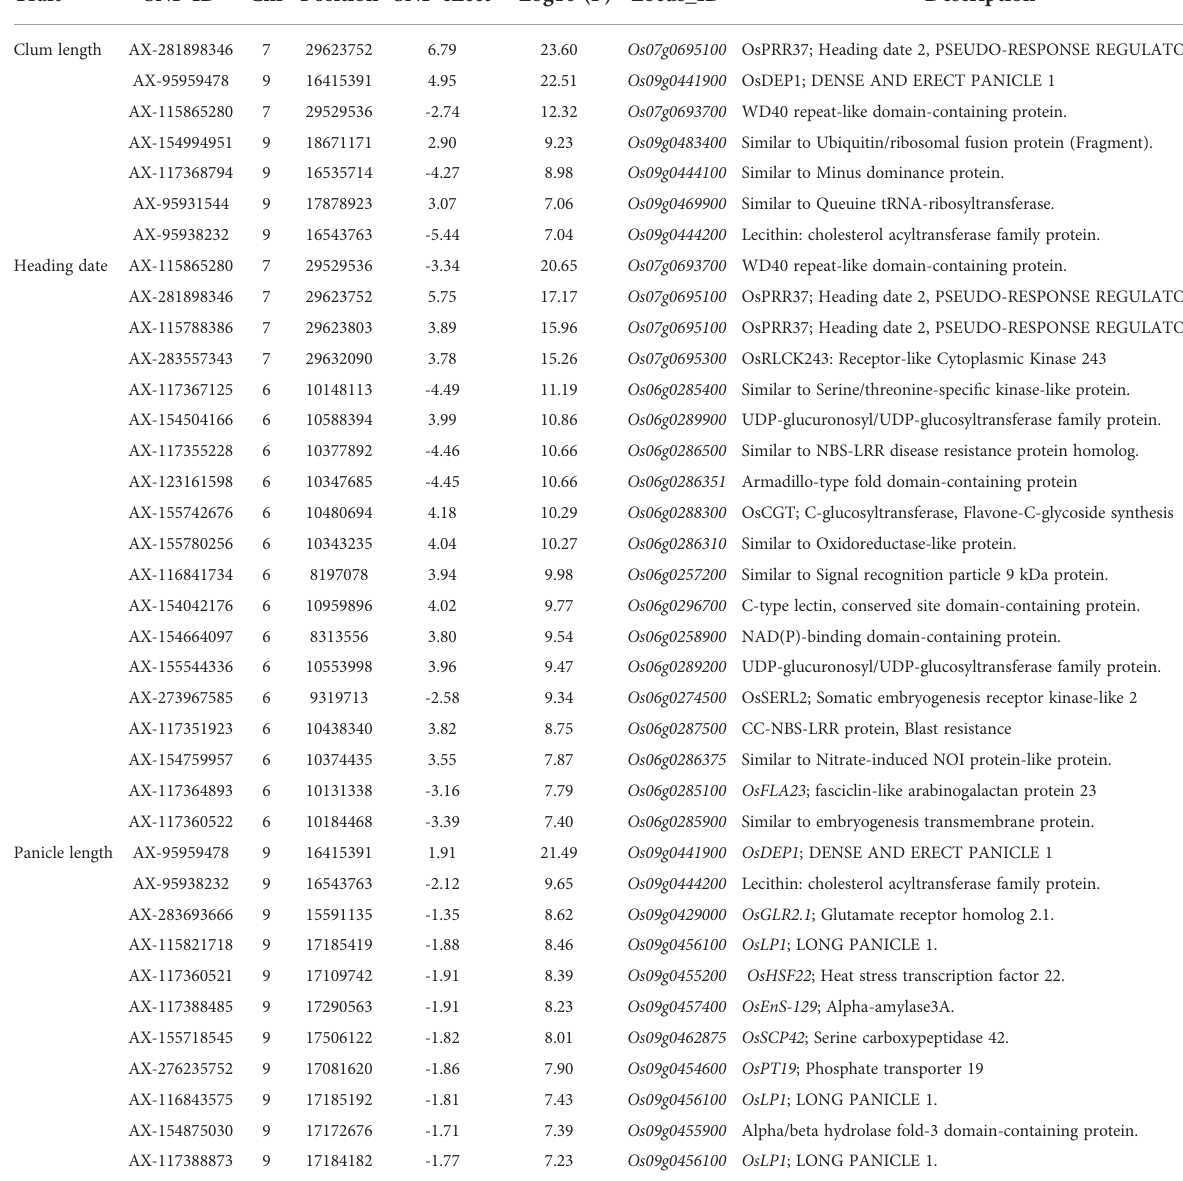
TABLE 2 List of genes identi fi ed from signi fi cantly associated SNPs for phenotypic traits. Trait SNP